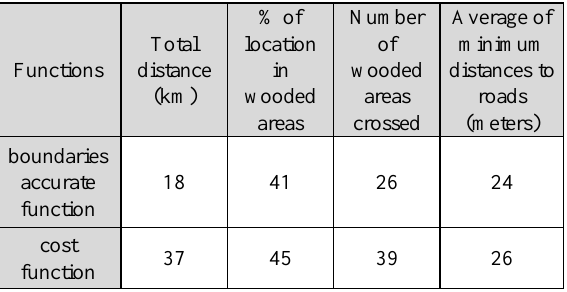
Table 3. Comparison of the two functions based on criteria, calculated for a 24 h simulation. Calculations are made from the simulated locations, related to geographical objects. The main difference lies in the total